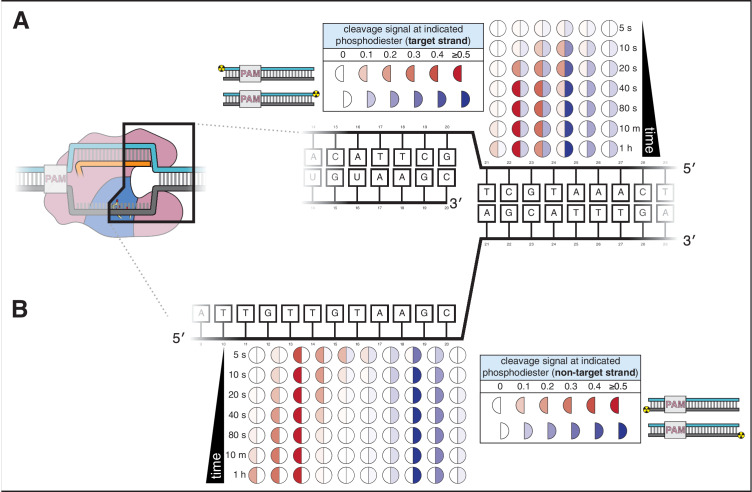
Cas12a forms a gap in the non-target strand and cleaves the target strand outside the R-loop.(A) Target-strand cleavage products over time, as quantified by denaturing PAGE. 100 nM AsCas12a and 120 nM crRNA were incubated with 5 nM radiolabeled DNA target at 37°C for the indicated timepoints, followed by quenching and resolution by denaturing PAGE. Representative phosphorimages are shown in Appendix 2—figure 1—figure supplement 1. Data shown here are the average of three replicates. Each circle denotes a phosphodiester at which cleavage was observed. The intensity of color in each half-circle (‘cleavage signal’) reflects the fraction (band volume for a given cleavage product) / (total volume in lane). The left half of each circle (red) corresponds to the cleavage product detected with a PAM-proximal radiolabel. The right half of each circle (blue) corresponds to the cleavage product detected with a PAM-distal radiolabel. (B) Non-target-strand cleavage products over time, as quantified by denaturing PAGE (phosphorimage in Appendix 2—figure 1—figure supplement 1). Data representation as in A.Appendix 2—figure 1—source data 1.Numerical data plotted in Appendix 2—figure 1 and accompanying figure supplements.